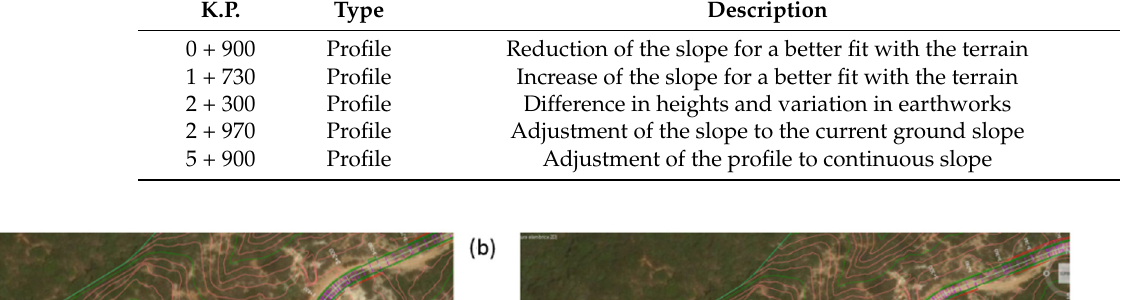
Table 2. Changes made to the road profile to generate the as-built model. K.P.